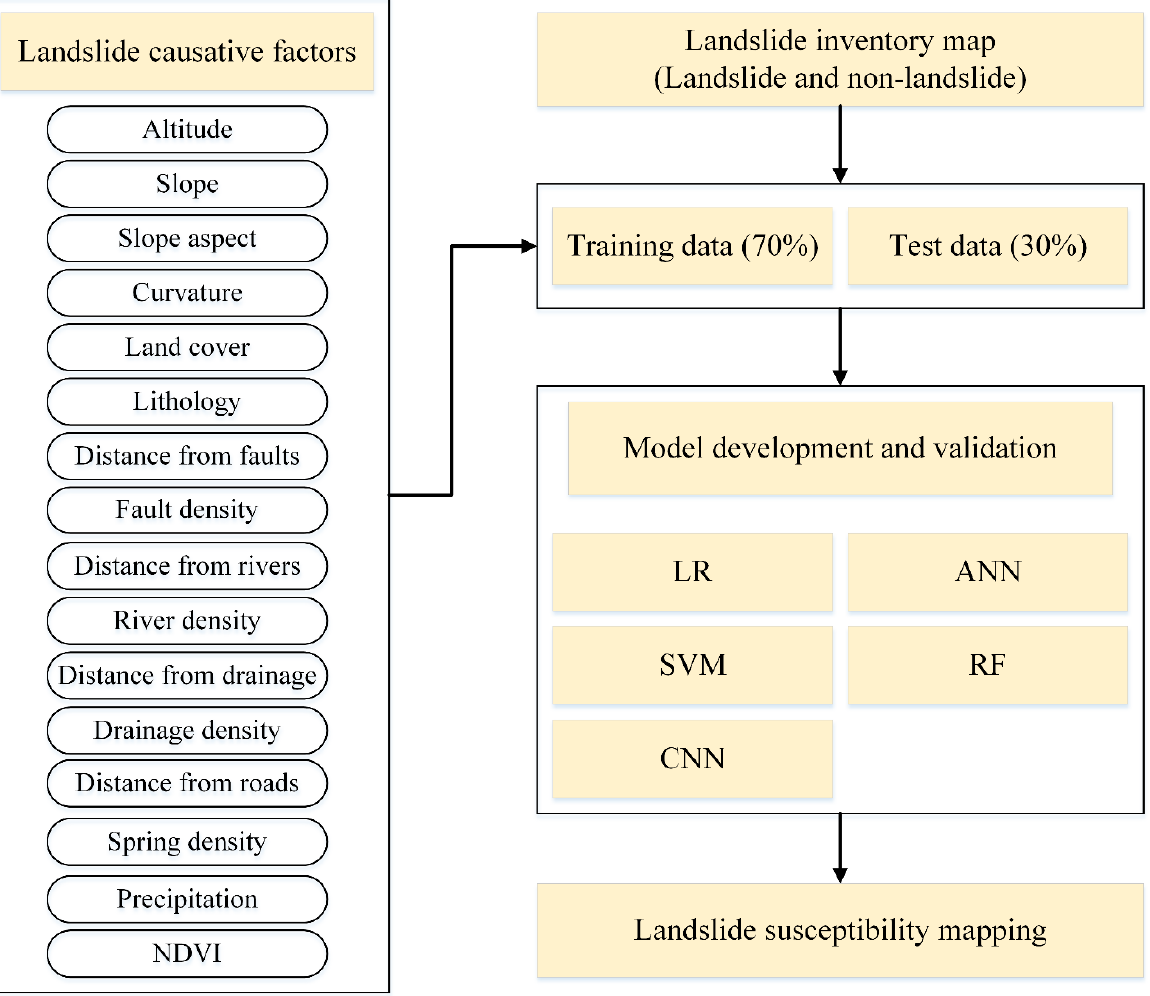
Figure 5. Framework for landslide susceptibility map.